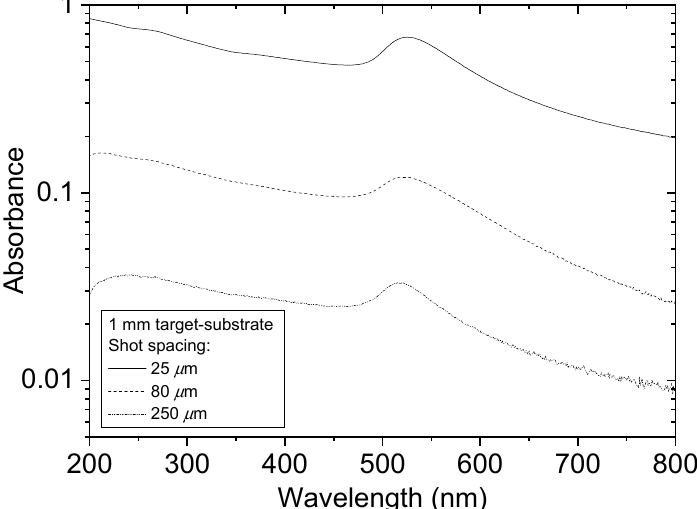
Figure 8. Optical absorbance spectra of Au NP films deposited at a target-substrate separation of 1 mm and with laser spot spacing of 25 µ m, 80 µ m, and 250 µ m in each direction.